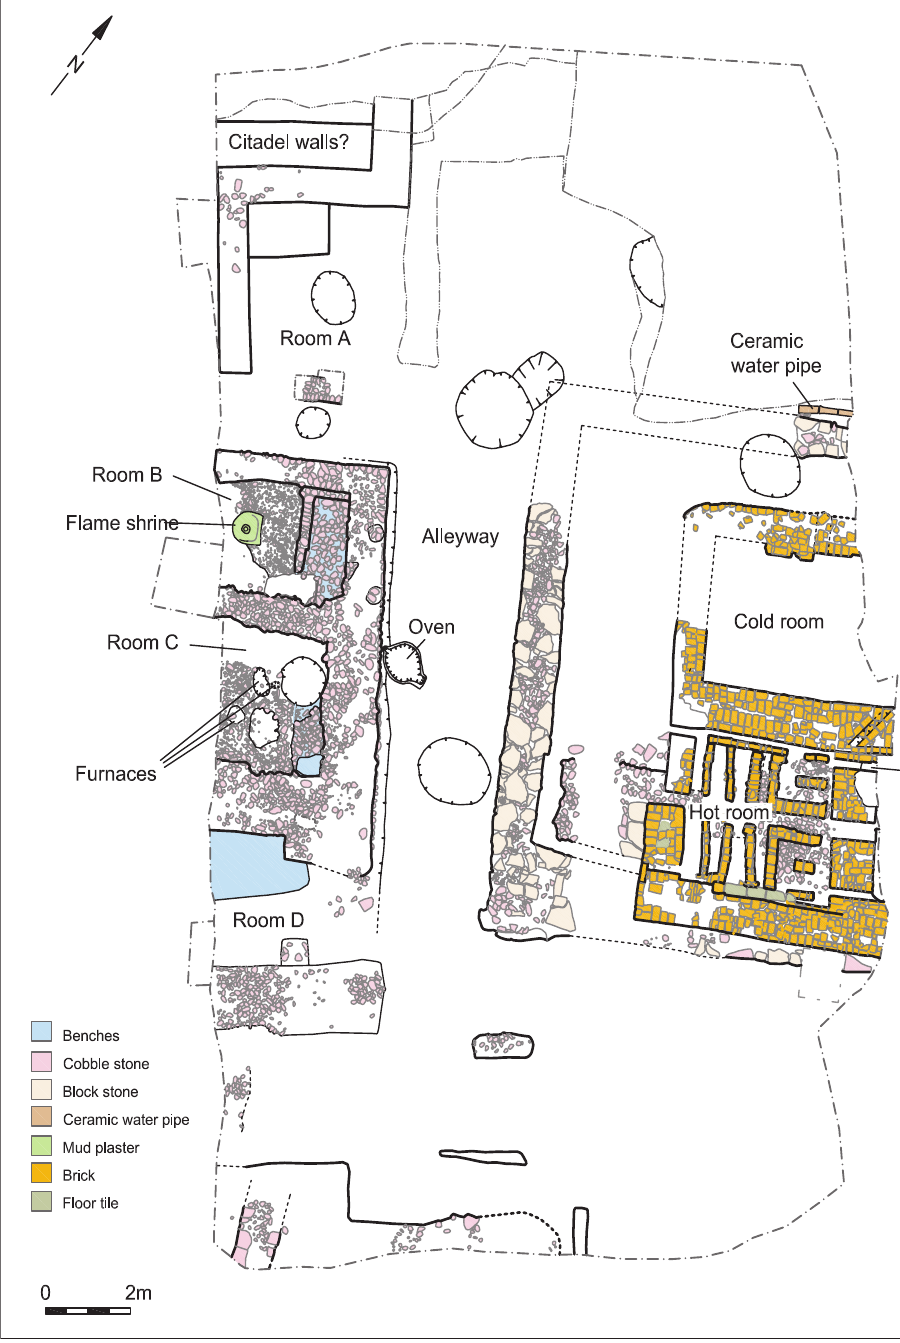
Fig. 6: Rooms B, C and D of Building